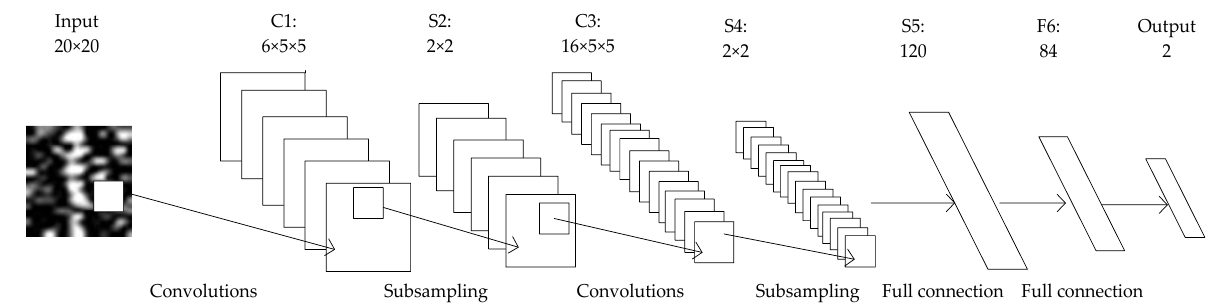
Figure 3. The structure diagram of the convolutional neural network in this paper.